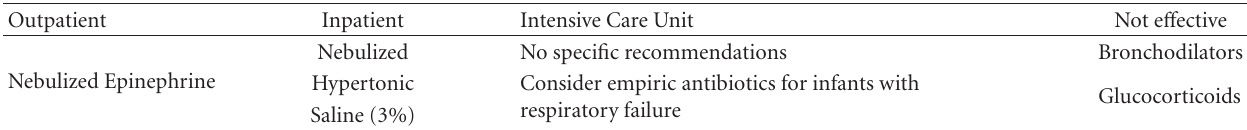
Table 2: Evidence-based treatment options for